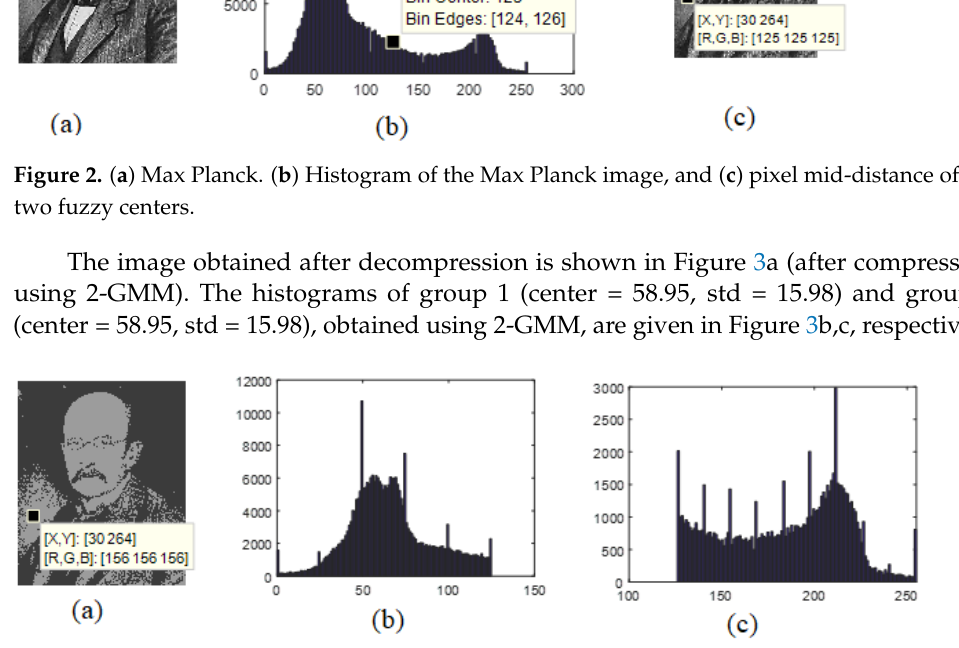
gram of group 1 pixels obtained using 2-GMM (center = 58.95, std = 15.98), and ( c ) the histogram of group 2 pixels obtained using 2-GMM (center = 155.61, std = 50.04).